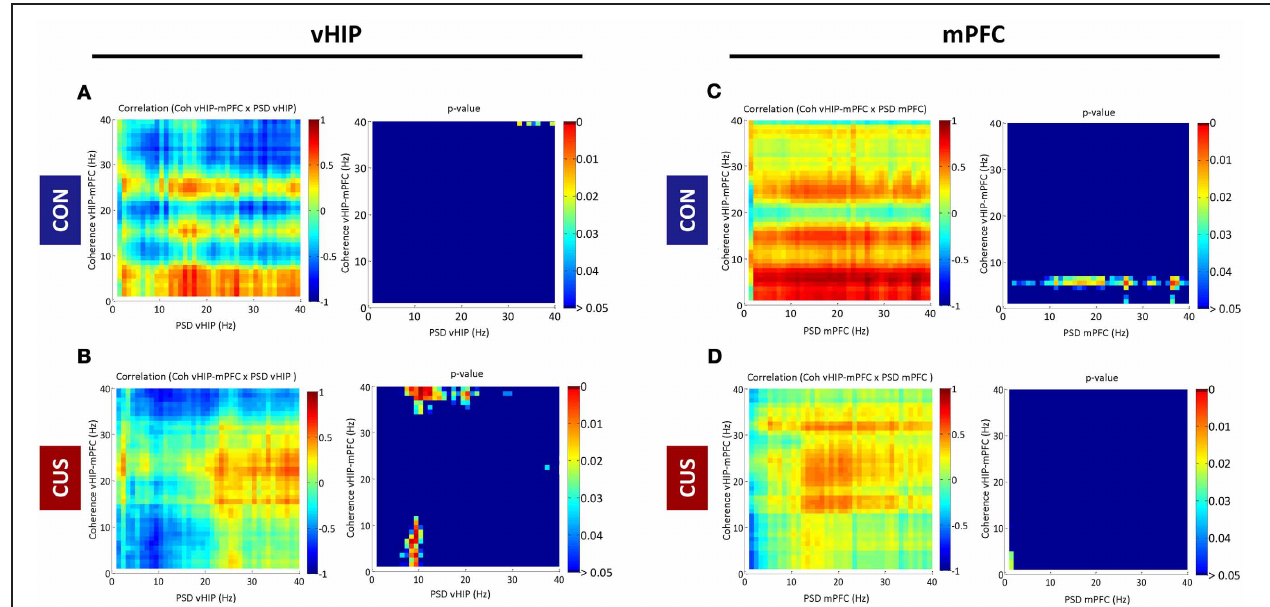
and CUS rats ( A,C and B,D , respectively). For each brain region, statistically significant correlations are represented in the right panel by color above dark blue ( p < 0 . 05); the direction of the correlation, positive or negative, is given in the left panel by the color code (green to red, positive correlation; green to blue, negative